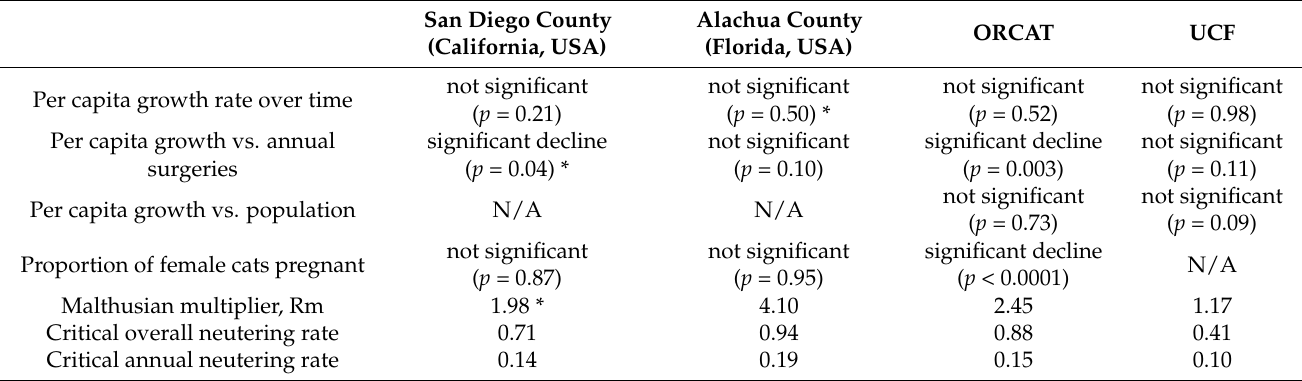
Table 3. Key metrics, as described by Foley et al. [22], applied to ORCAT and UCF TNR programs. Results from the original study (San Diego and Alachua counties) are included for reference (data were approximated based on the plots provided in the original publication—see Figure